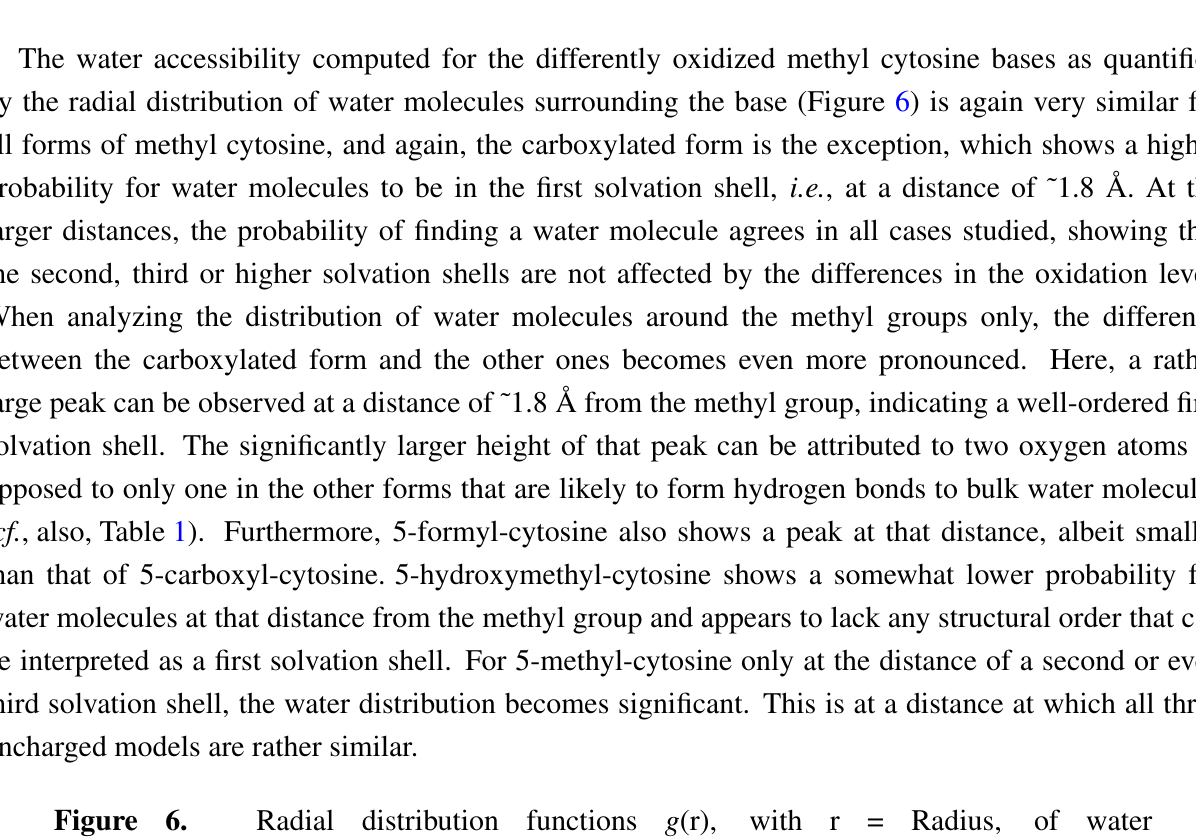
Figure 6. Radial distribution functions g (r), with r = Radius, of water surrounding ( a ) the base and ( b ) the (oxidized) methyl groups in the central 5-methyl-cytosine (green), 5-hydroxymethyl-cytosine (maroon), 5-formyl-cytosine (blue) and 5-carboxyl-cytosine